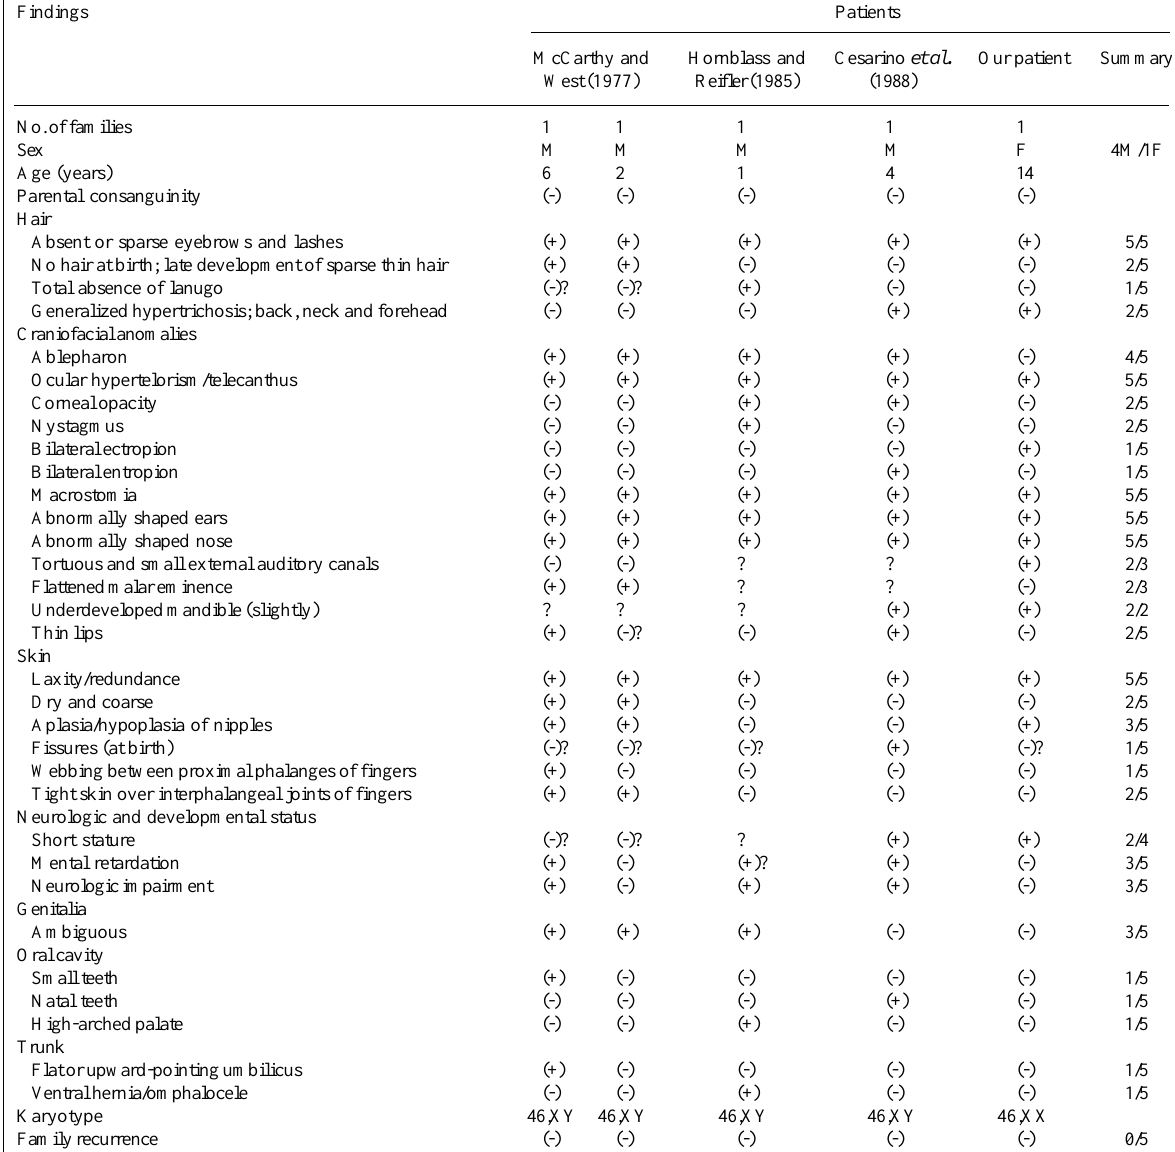
Table II - Differential diagnosis with Ablepharon-Macrostomia